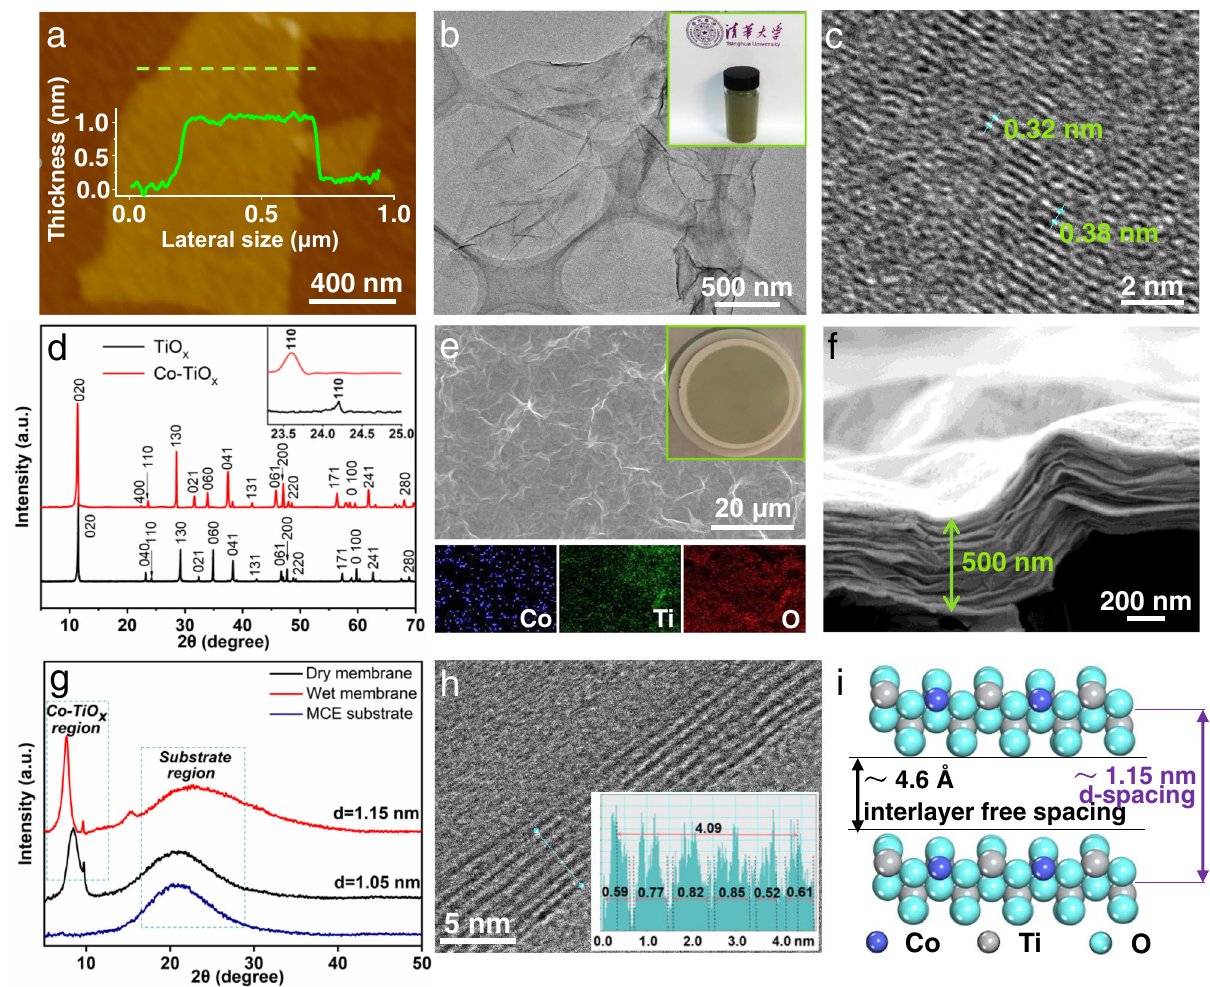
Fig. 2 Synthesis and microanalysis of the Co-TiO x membrane. a AFM image and corresponding height pro fi le (green dashed line), b TEM image and (inset) corresponding aqueous colloidal solution, and c HRTEM image of Co-TiO x nanosheets. d XRD patterns of parent layered TiO x and Co-TiO x powders, and (inset) the magni fi ed XRD patterns at low Bragg angles. e SEM image and EDX mapping of Co-TiO x membrane, and (inset) photograph of Co-TiO x membrane on MCE support. f Cross-sectional SEM image. g XRD patterns in both dried and hydrated states of Co-TiO x membrane. h Cross-sectional HRTEM image, and (inset) grayscale pro fi le of partial Co-TiO x membrane sonicated. i Illustration of the interlayer free spacing and d -spacing between neighboring Co-TiO x nanosheets in the membrane (hydrated